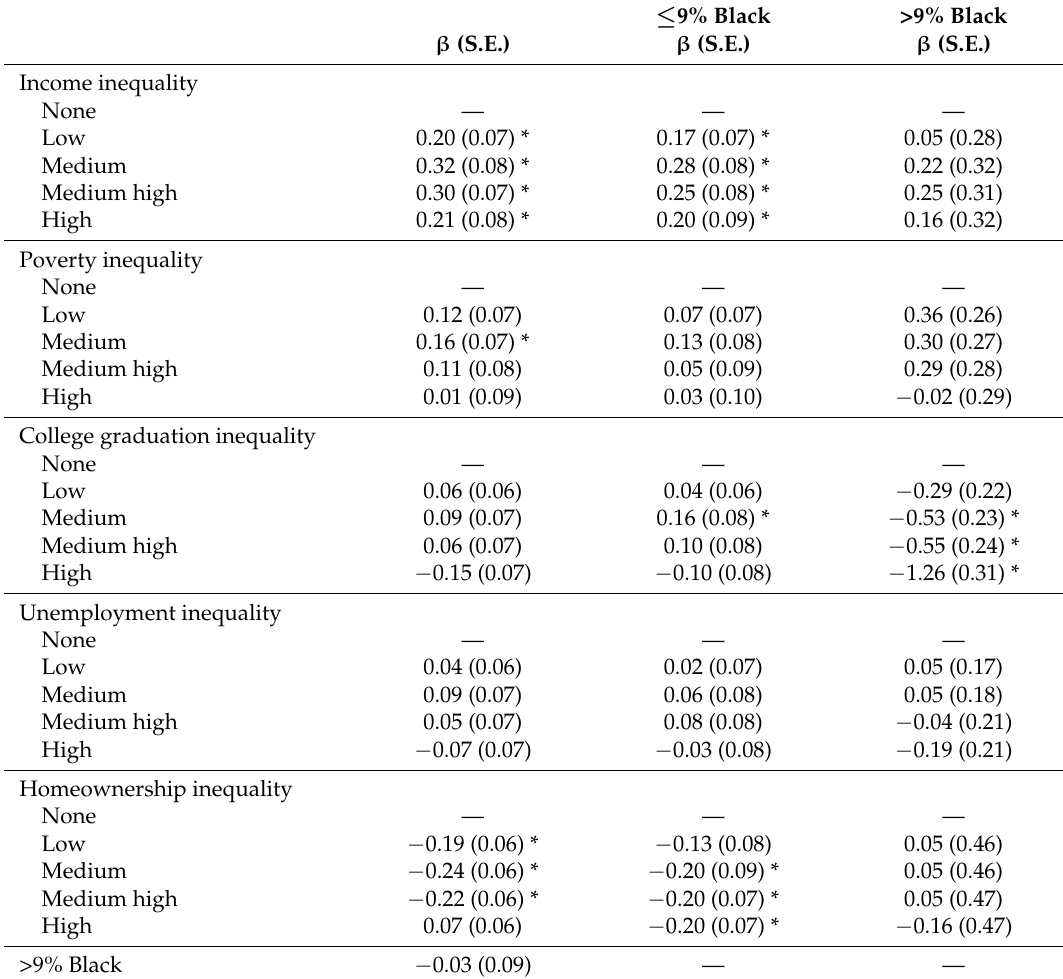
Table 5. Associations between indicators of structural racism and fast food / grocery store ratio by racial composition in U.S. county-years, 2012–2016. ≤ 9% Black >9% Black β (S.E.) β (S.E.) β